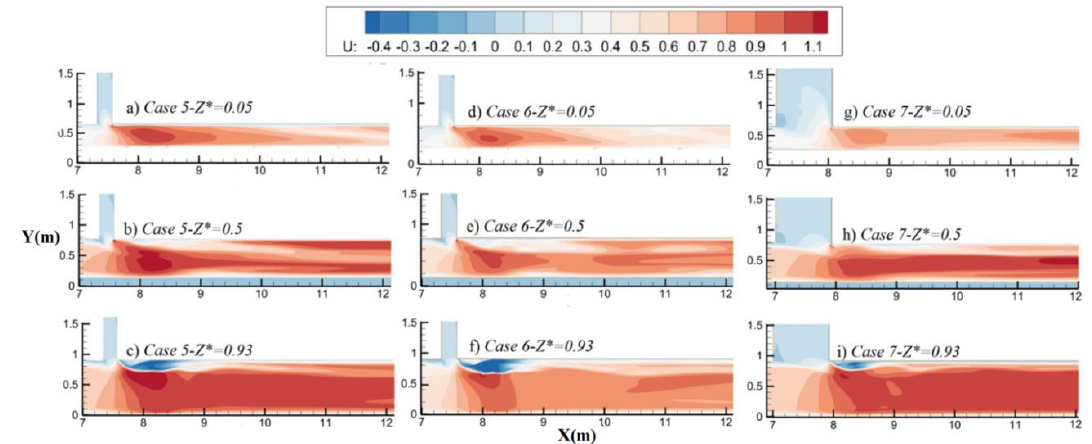
Figure 9. The distribution of the stream-wise component of velocity (U) in trapezoidal channel.